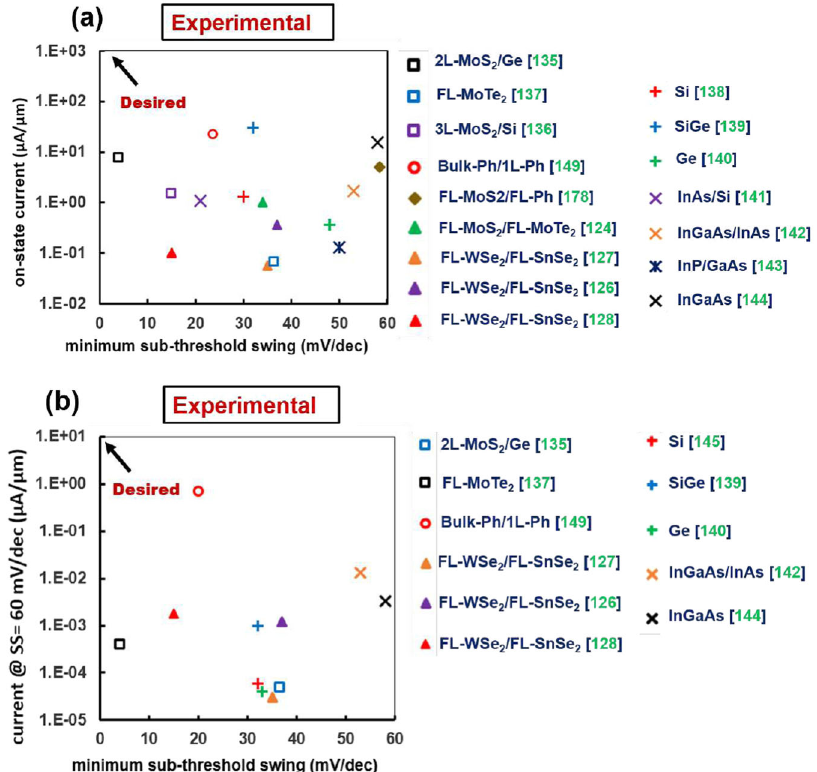
Fig. 29 Performance of Experimentally Realized 2D-TFETs. Comparative plots of a I on – vs SS min 1 V gate and drain bias b I 60 – vs SS min at 1 V drain bias for experimentally reported 2D- and bulk-